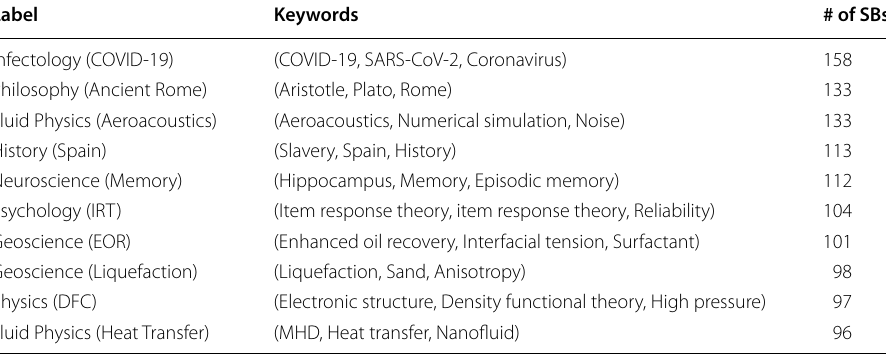
The table extended to the top 50 is presented in Table 14